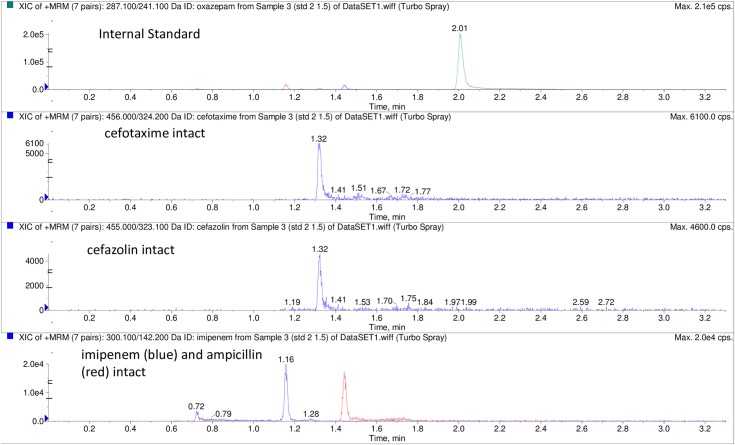
MRM (multiple reaction monitoring) chromatogram showing intact profiles of cefazolin, cefotaxime, imipenem and ampicillin respectively.The intact profiles were demonstrated after incubation of the antibiotic mixture with E.coli ATCC 25922 (sample 3). The profile of the internal standard (oxazepam) is shown above the profiles of the intact antibiotic panel.